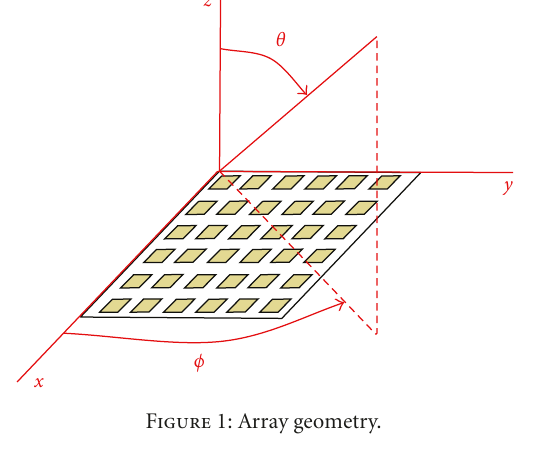
Figure 1: Array geometry.